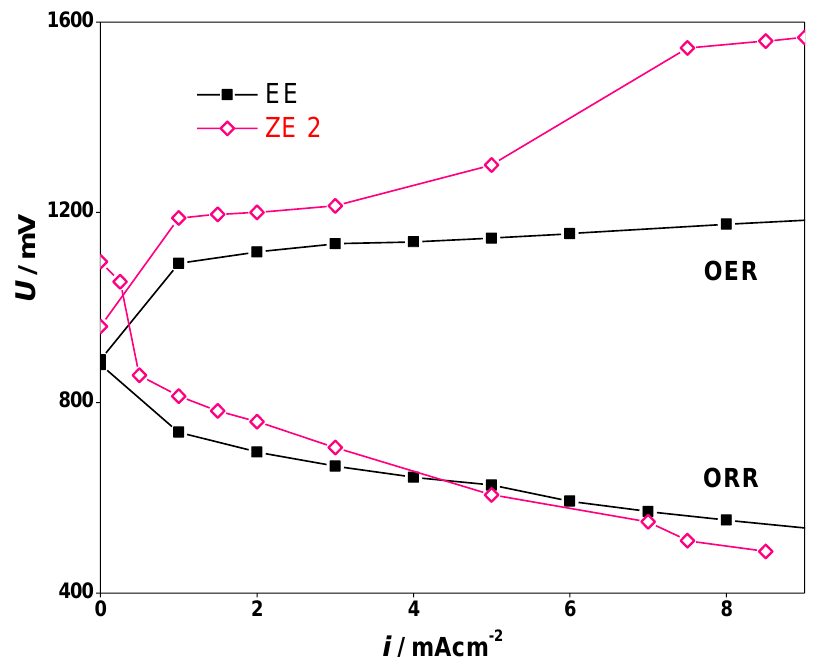
Figure 3. Volt-ampere characteristics during discharge (ORR) and charge (OER) measured on AE with impregnated zeolite-based GDL (ZE 2) compared with the etalon carbon-based GDE